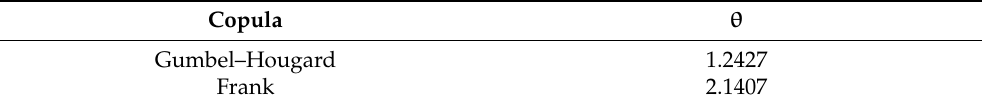
Table 3. θ parameter for the analysed copulas.